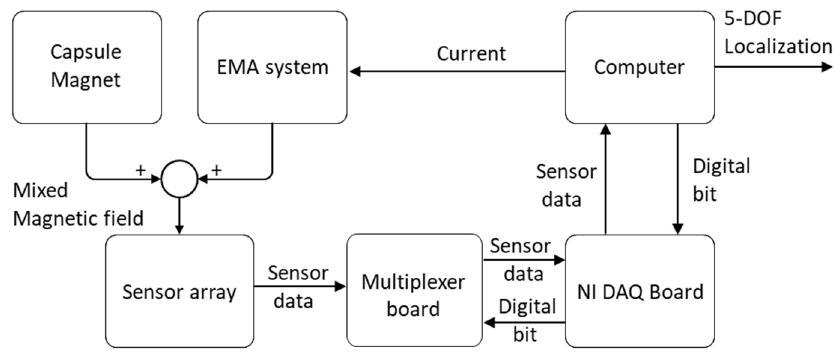
Figure 3. Diagram of data acquisition and compensation method.